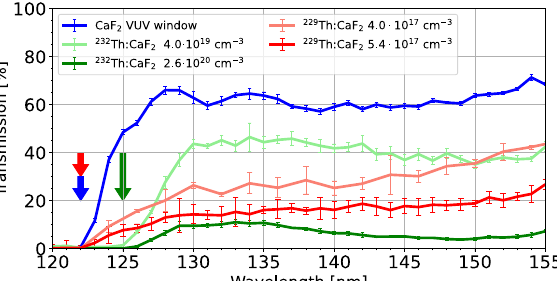
Figure 3. Representative spectral transmissions of 232 Th:CaF 2 and 229 Th:CaF 2 with different